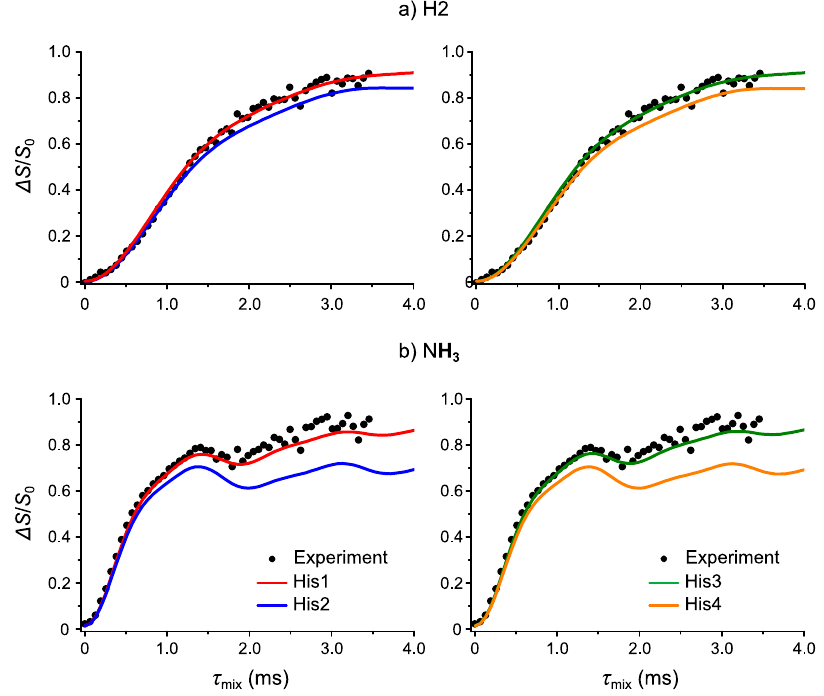
Figure 4. Comparison of the experimental 1 H- 14 N phase-modulated rotational-echo saturation-pulse double-resonance (PM-S-RESPDOR) fraction curves (black circles) with the simulated curves of His1 (red), His2 (blue), His3 (green), His4 (orange) for ( a ) H2 and ( b ) NH 3 .